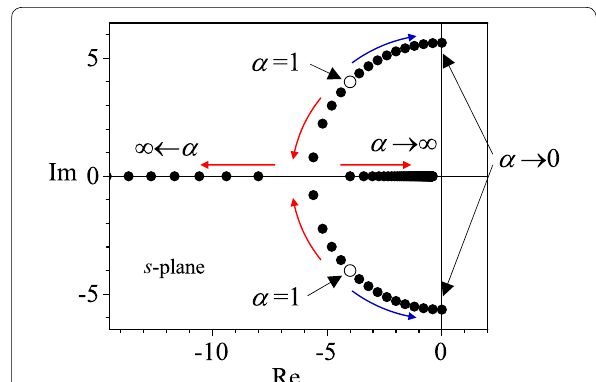
Fig. 9 Roots of the characteristic Eq. (5) when α is changed, ( k 1 , k